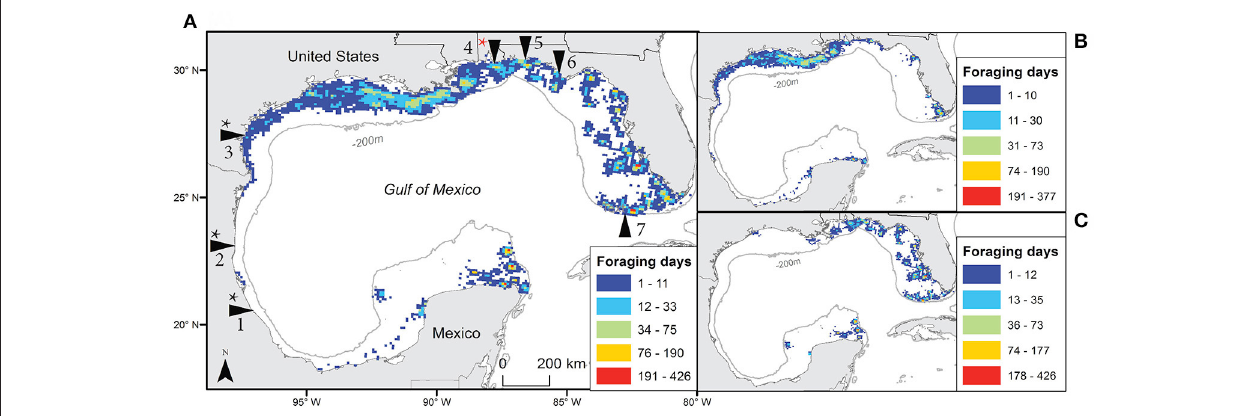
FIGURE 1 | The number of days individual turtles used each 10km grid cell throughout the Gulf of Mexico during foraging periods using filtered satellite locations for both species (A) , Kemp’s ridley (B) , and loggerhead (C) . Tagging sites are indicated in main panel with arrows: from the bottom left moving clockwise they include Veracruz (Mexico); Rancho Nuevo, Tamaulipas (Mexico); Padre Island National Seashore, Texas (USA); Gulf Shores, Alabama (USA); Eglin Air Force Base, Florida (USA); St. Joseph Peninsula, Florida (USA); and Dry Tortugas National Park, Florida (USA). Black * indicates sites where Kemp’s ridleys were tagged; red * indicates site where both species were tagged ( n = 1 Kemp’s ridley), 1-7 added for locations as in